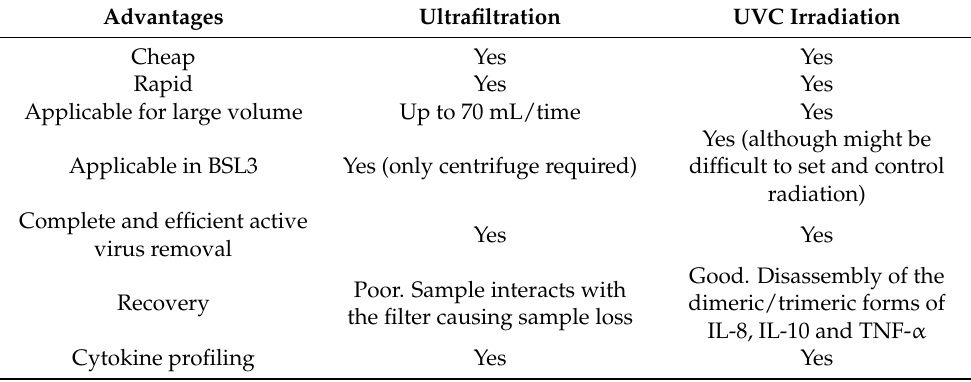
Table 2. Comparison of the two decontamination techniques (by virus removal by ultrafiltration [28] or UVC inactivation) used in this